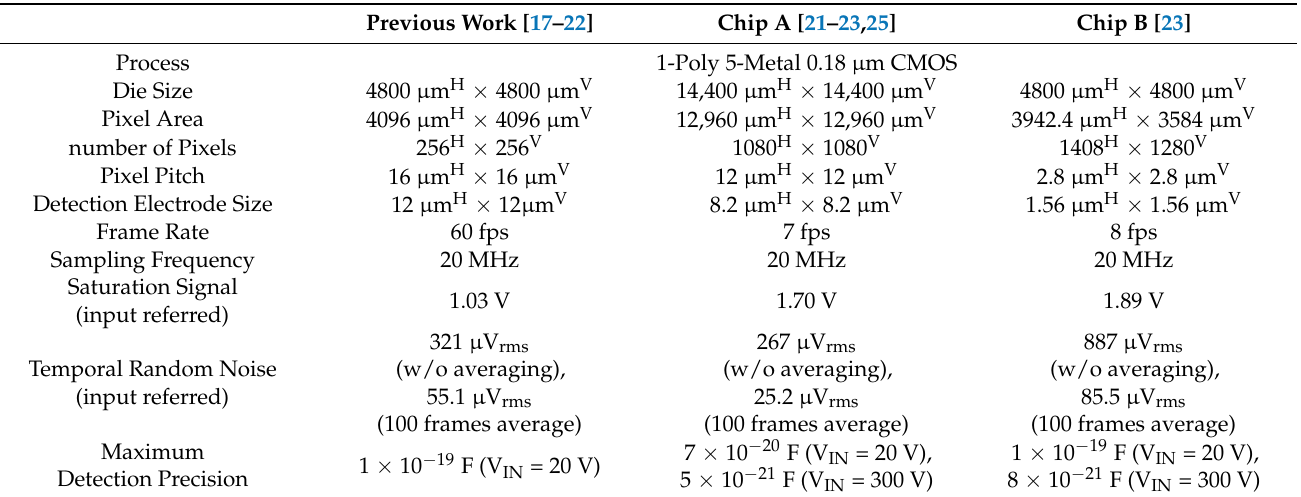
Table 2. Performance summary of the developed sensors.